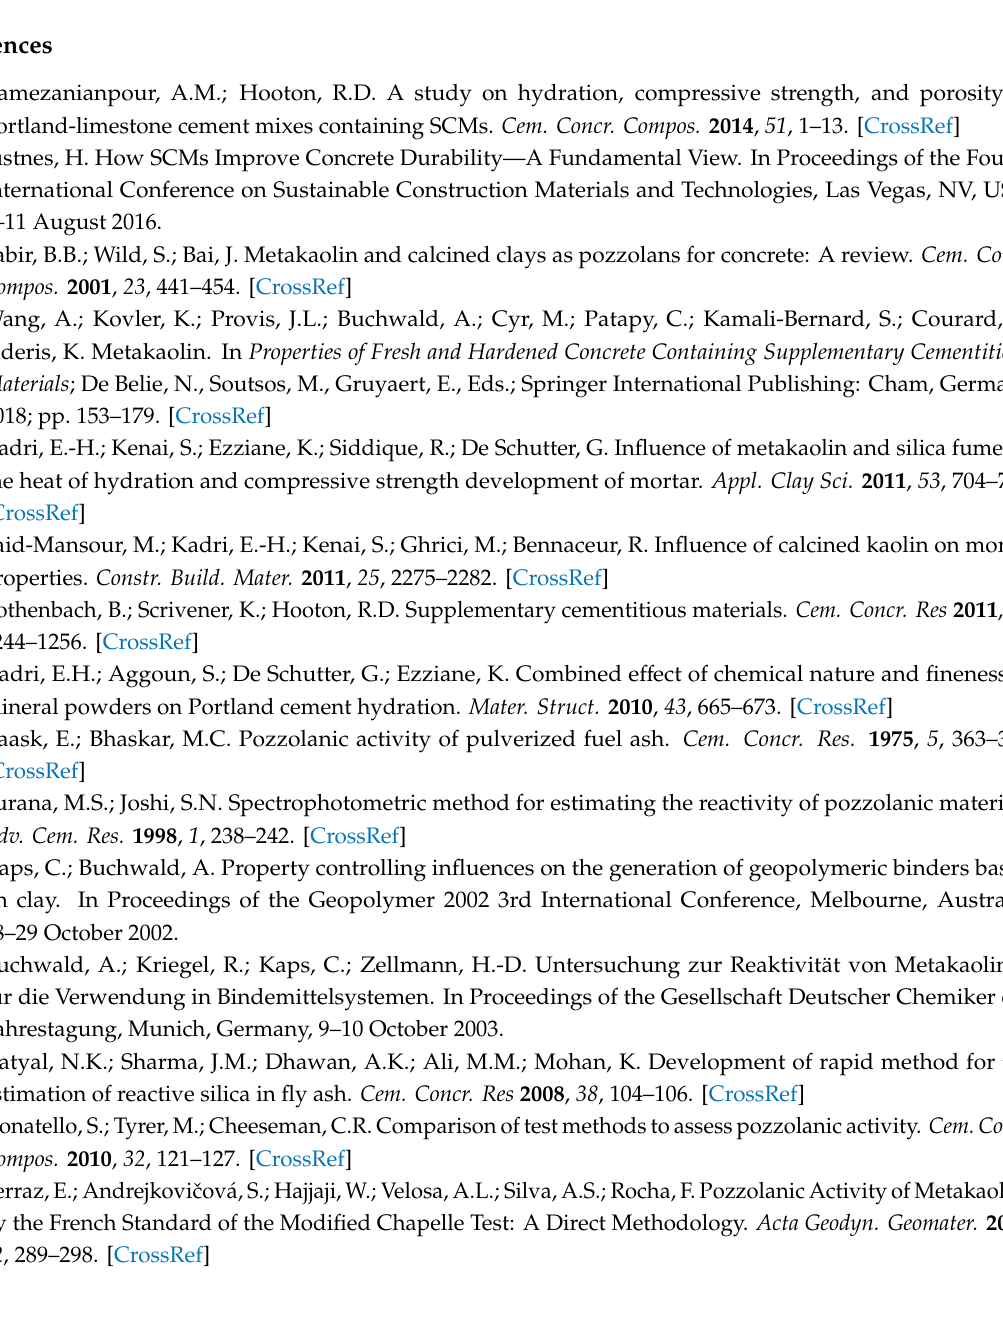
Table S1: Chemical composition [wt.%] of MK Am left after dissolution with di ff erent solvents of all samples measured with EDX and the molar ratio of SiO 2 / Al 2 O 3 and SiO 2 / (Al 2 O 3 + Fe 2 O 3 + TiO 2 + Na 2 O + K 2